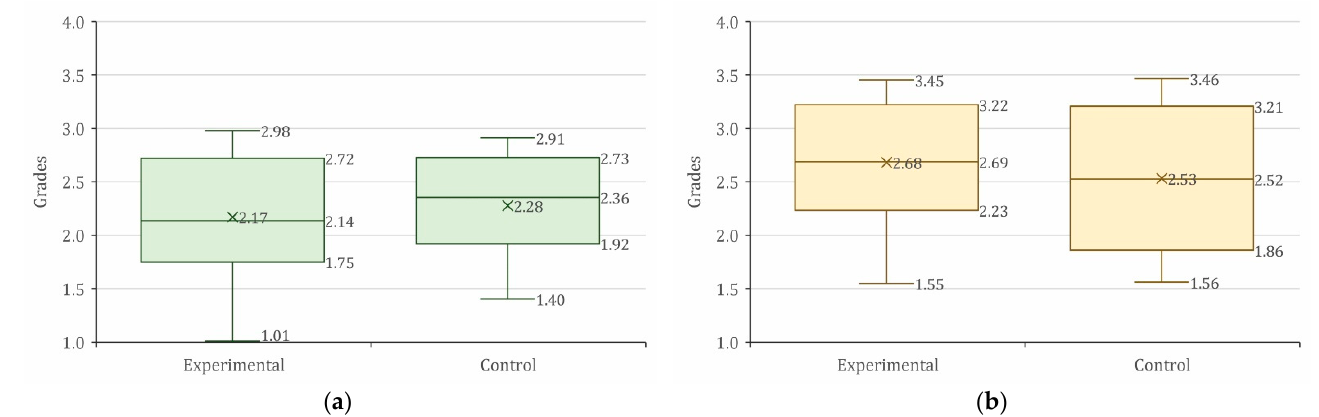
Figure 4. Pre-test results. ( a ) Computer Programming; ( b ) Graphic Programming.